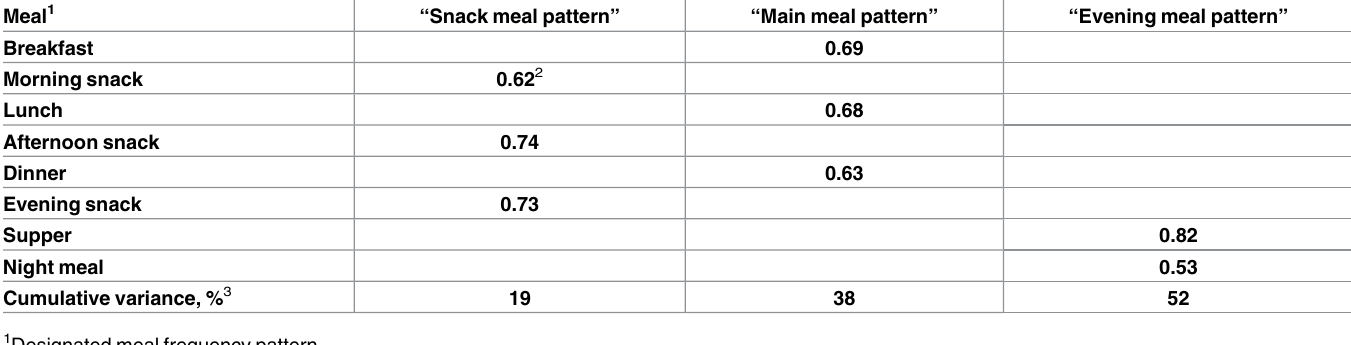
Table 1. Structures of the three orthogonally rotated factors (meal frequency patterns) identified using principal component factor analysis in 65,487 women in the Mother and Child Cohort Study